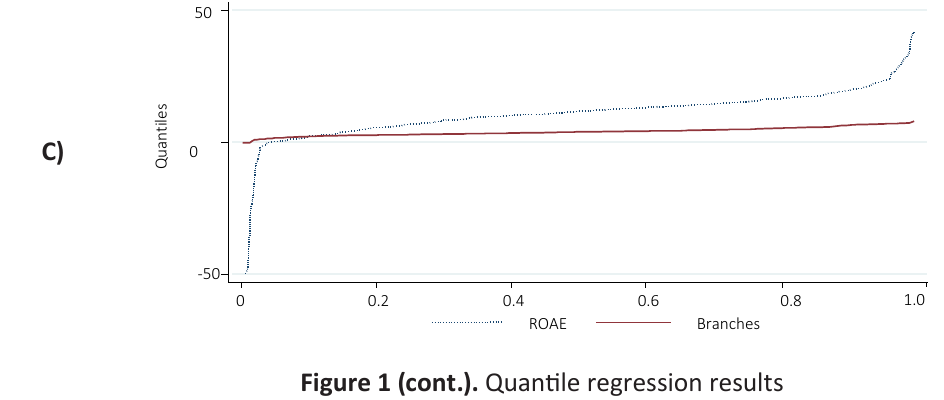
Figure 1 (cont.). Quantile regression